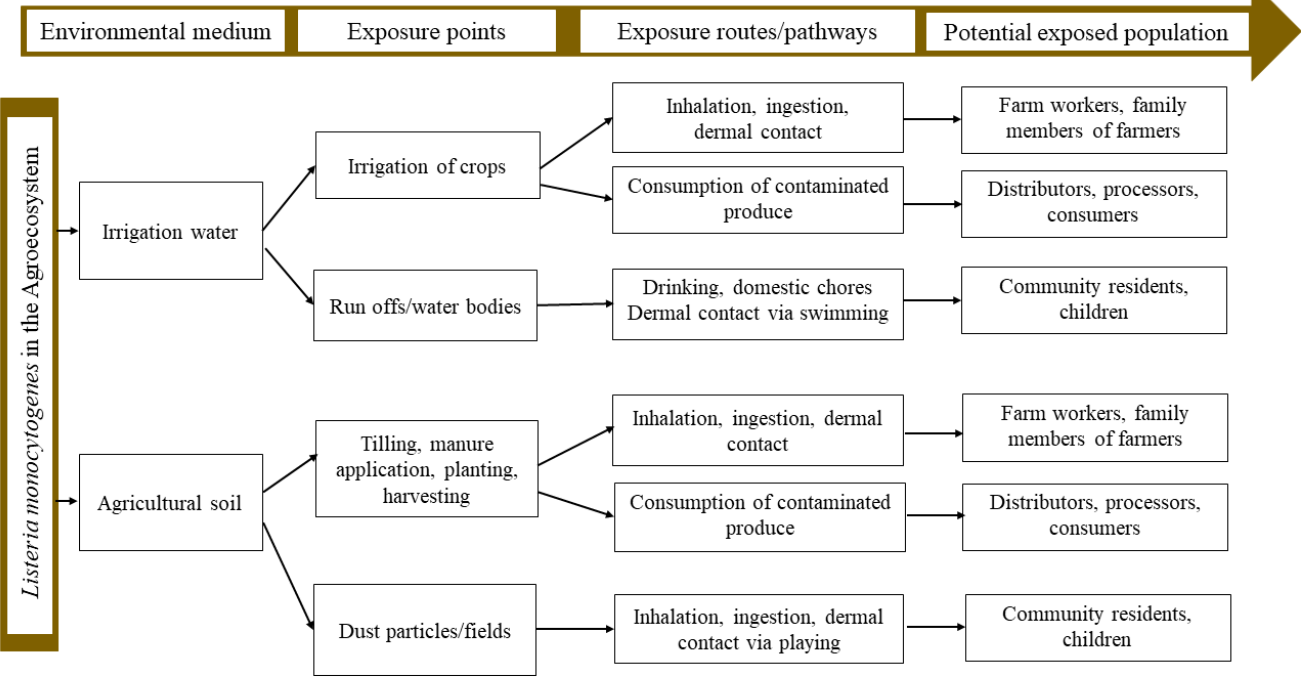
Figure 4. The human exposure patterns showing possible ways humans can be exposed to L. monocytogenes in irrigation water and agricultural soil. Table 4. The exposure parameters in adults and children.